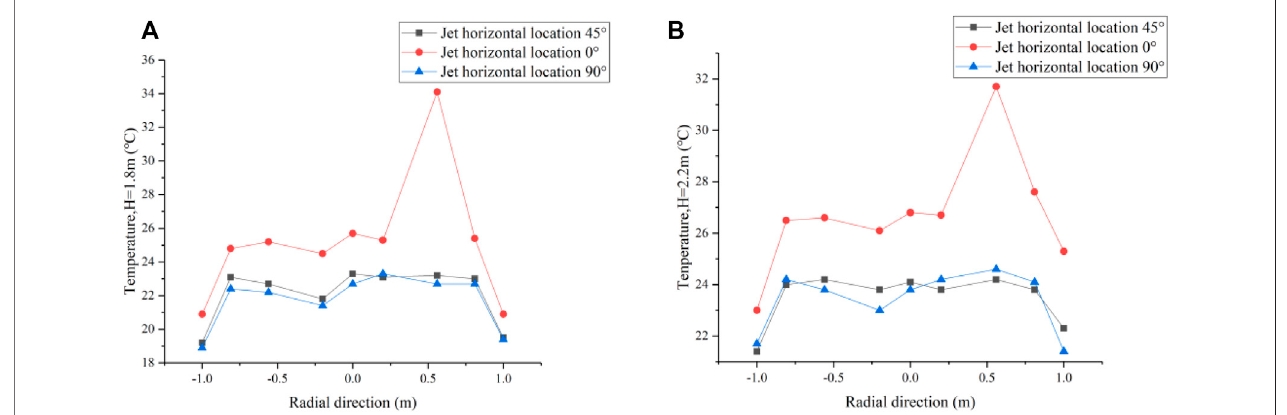
FIGURE 5 | Radial temperature distribution at H = 1.8 m and H = 2.2 m under different jet positions. (A) H = 1.8 m. (B) H = 2.2 m.